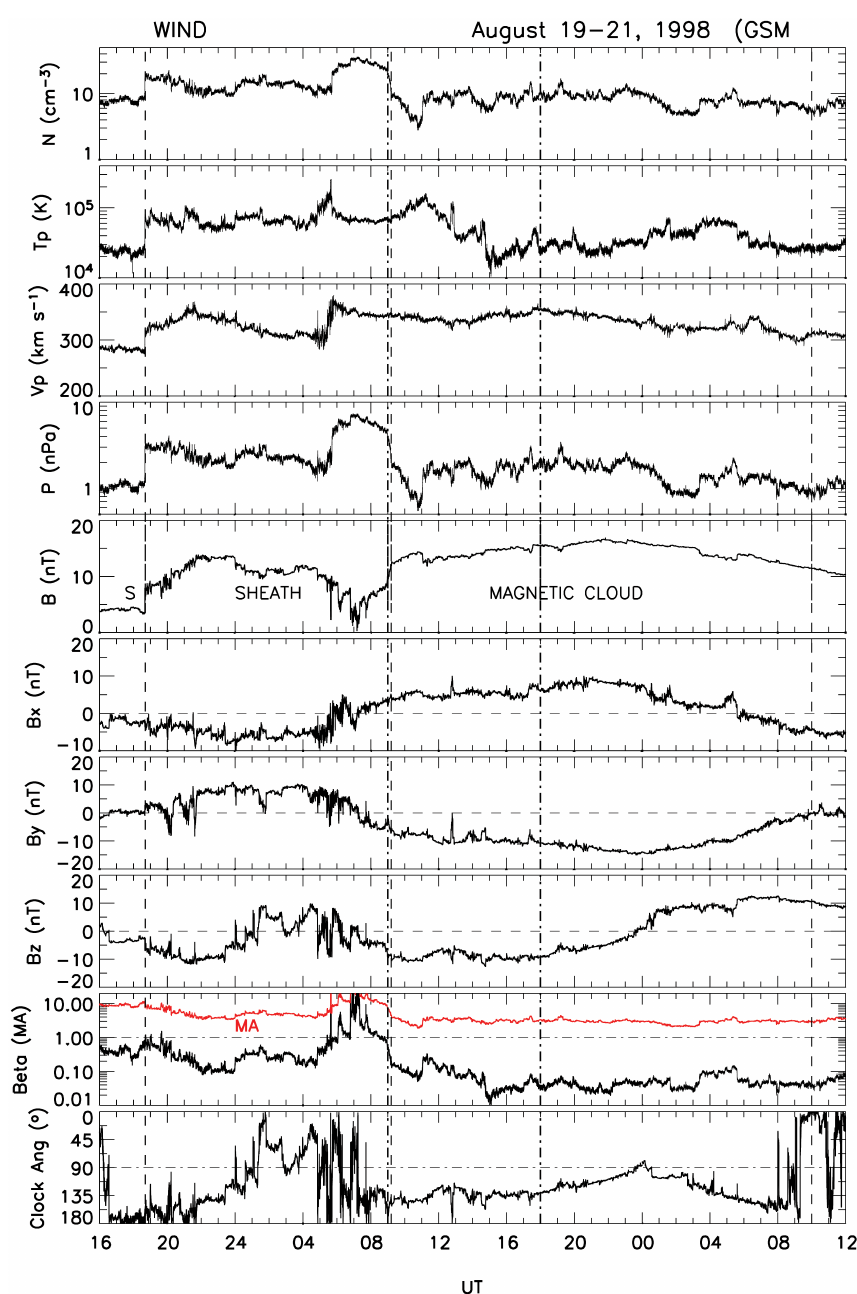
Fig. 8. Solar wind plasma and IMF observations from spacecraft Wind during the interval 16:00UT (19 August)–12:00UT (21 August), 1998. Panels from top to bottom shows (i) proton density, (ii) proton temperature, (iii) bulk speed, (iv) solar wind dynamic pressure, (v) IMF total field, (vi-viii) the field components B x , B y , B z , (ix) Alfv´en-Mach number (red) and proton beta, and (x) the IMF clock angle ( θ ). The shock, sheath, and the cloud proper are marked by vertical